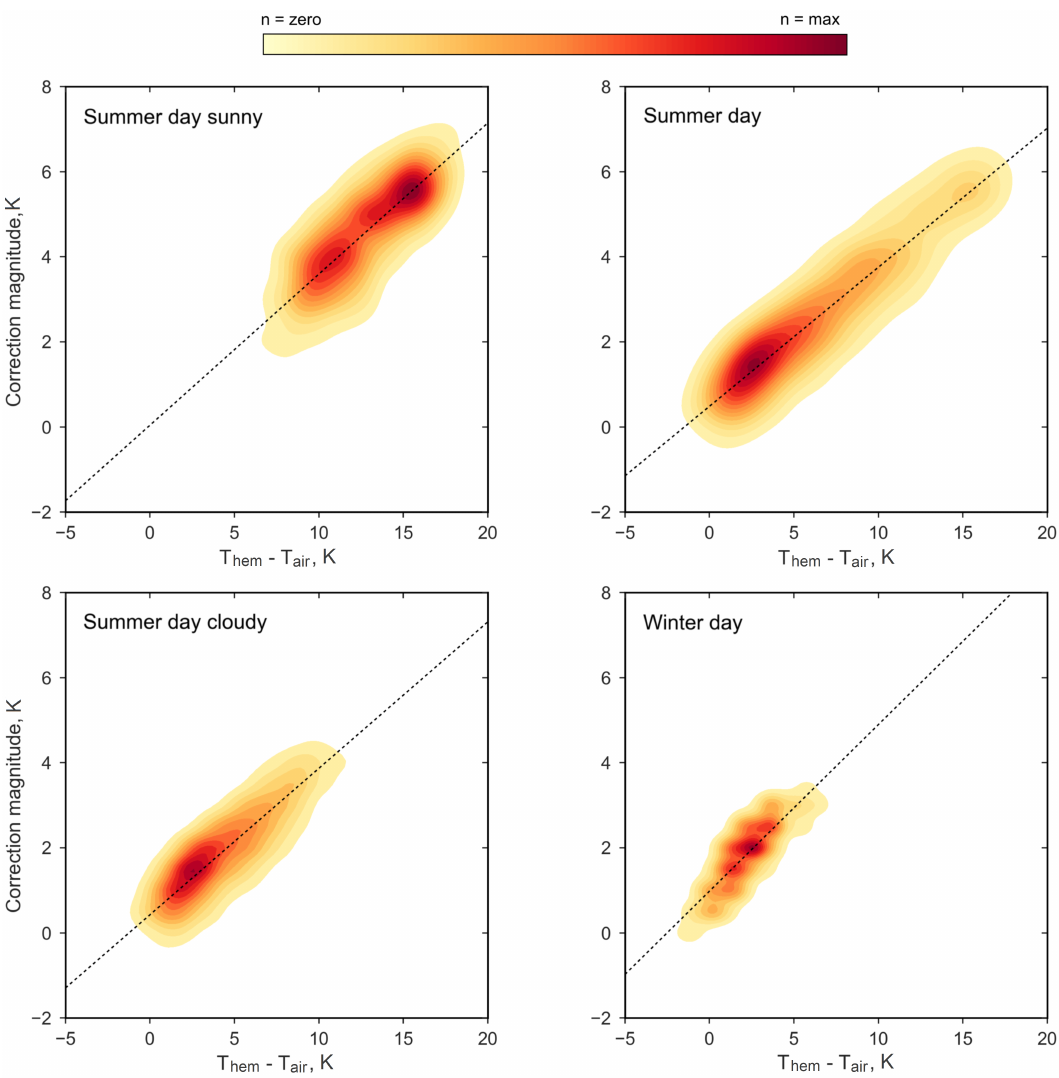
Figure 9. Correction magnitude versus ∆ T hem, r − air binned for cloudy and sunny conditions during the daytime hours of the summer months (May 2002–July 2002), and for winter (December 2001–March 2002) and summer